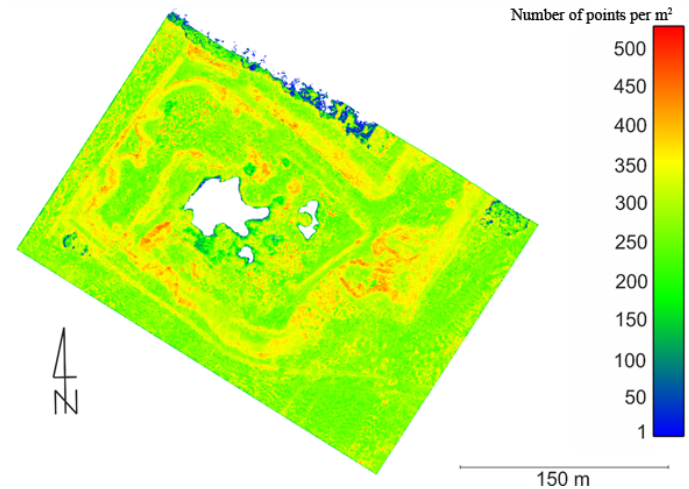
Figure 24. Density distribution of the entire generated point cloud.